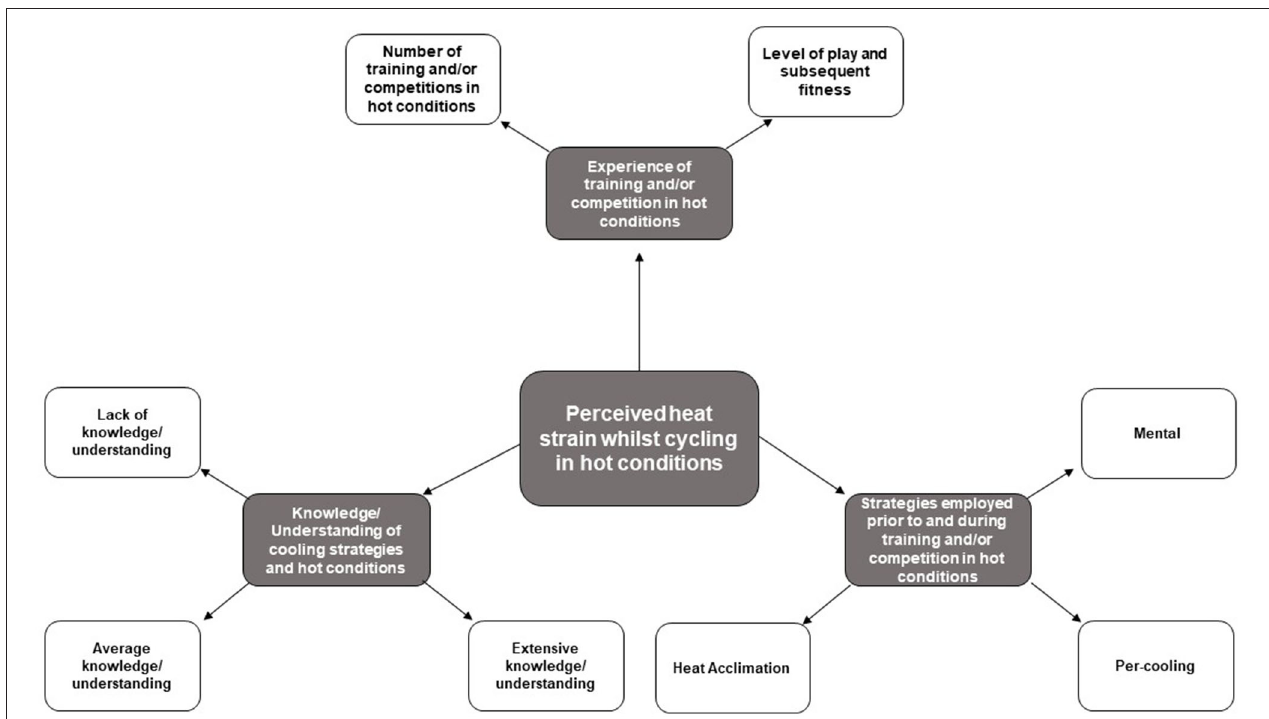
FIGURE 6 | Potential factors influencing perceived heat strain during cycling in hot conditions based on the experiences of 3 cyclists-triathletes. Themes are shaded in grey boxes and subthemes are in white boxes.